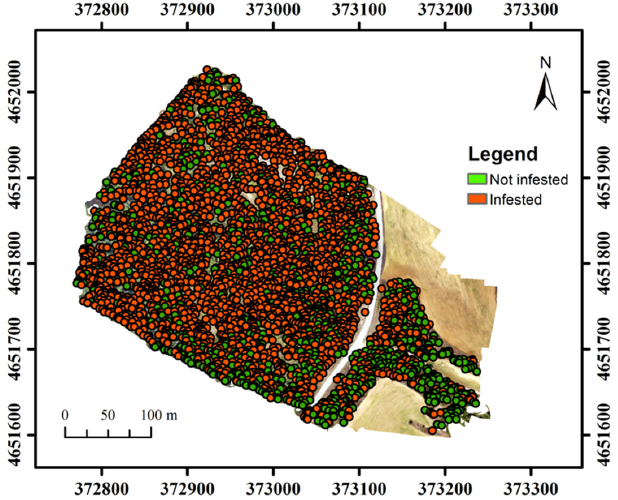
Figure 6. Pine processionary moth infestation in Torregassa ( A ) and Bosquet ( B ) forests. Forests 2017 , 8 , 402